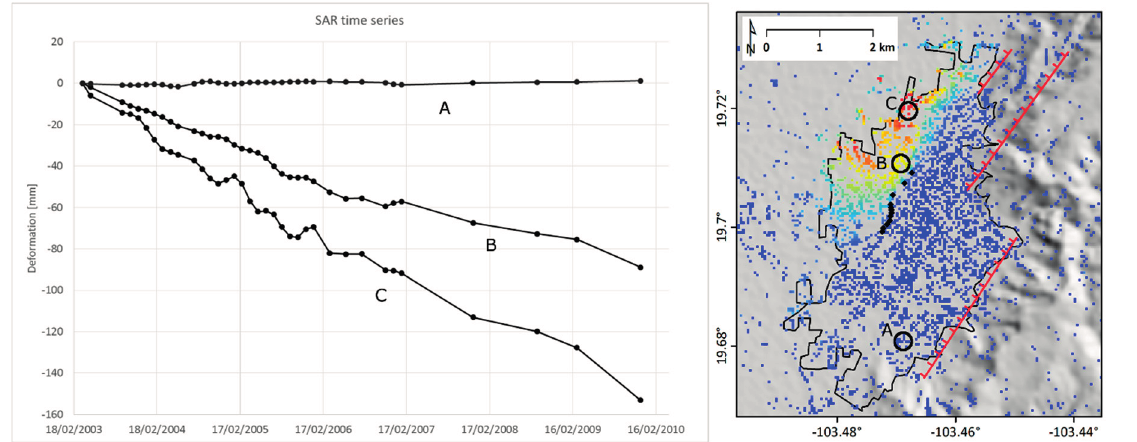
Figure 6. Example of three deformation histories estimated by the Multi-Baseline approach on ENVISAT ascending dataset. Curves A, B, and C are related to the points depicted in the inset (black